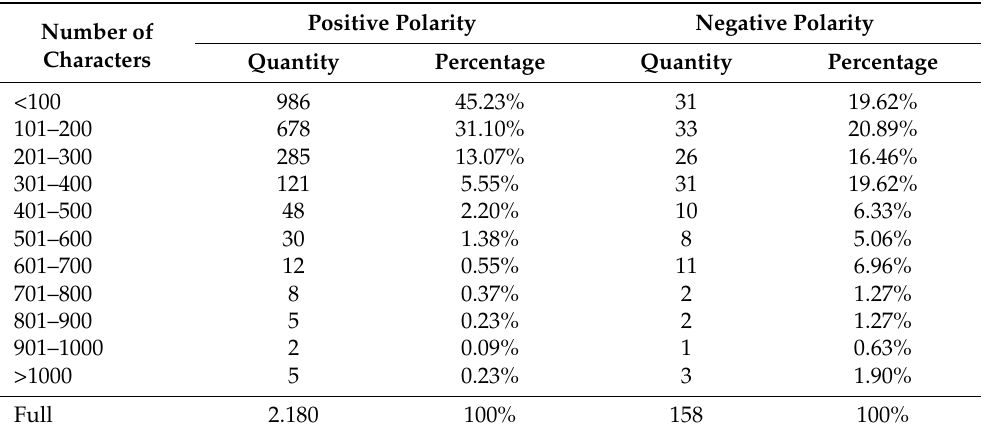
Table 2. Size distribution of the